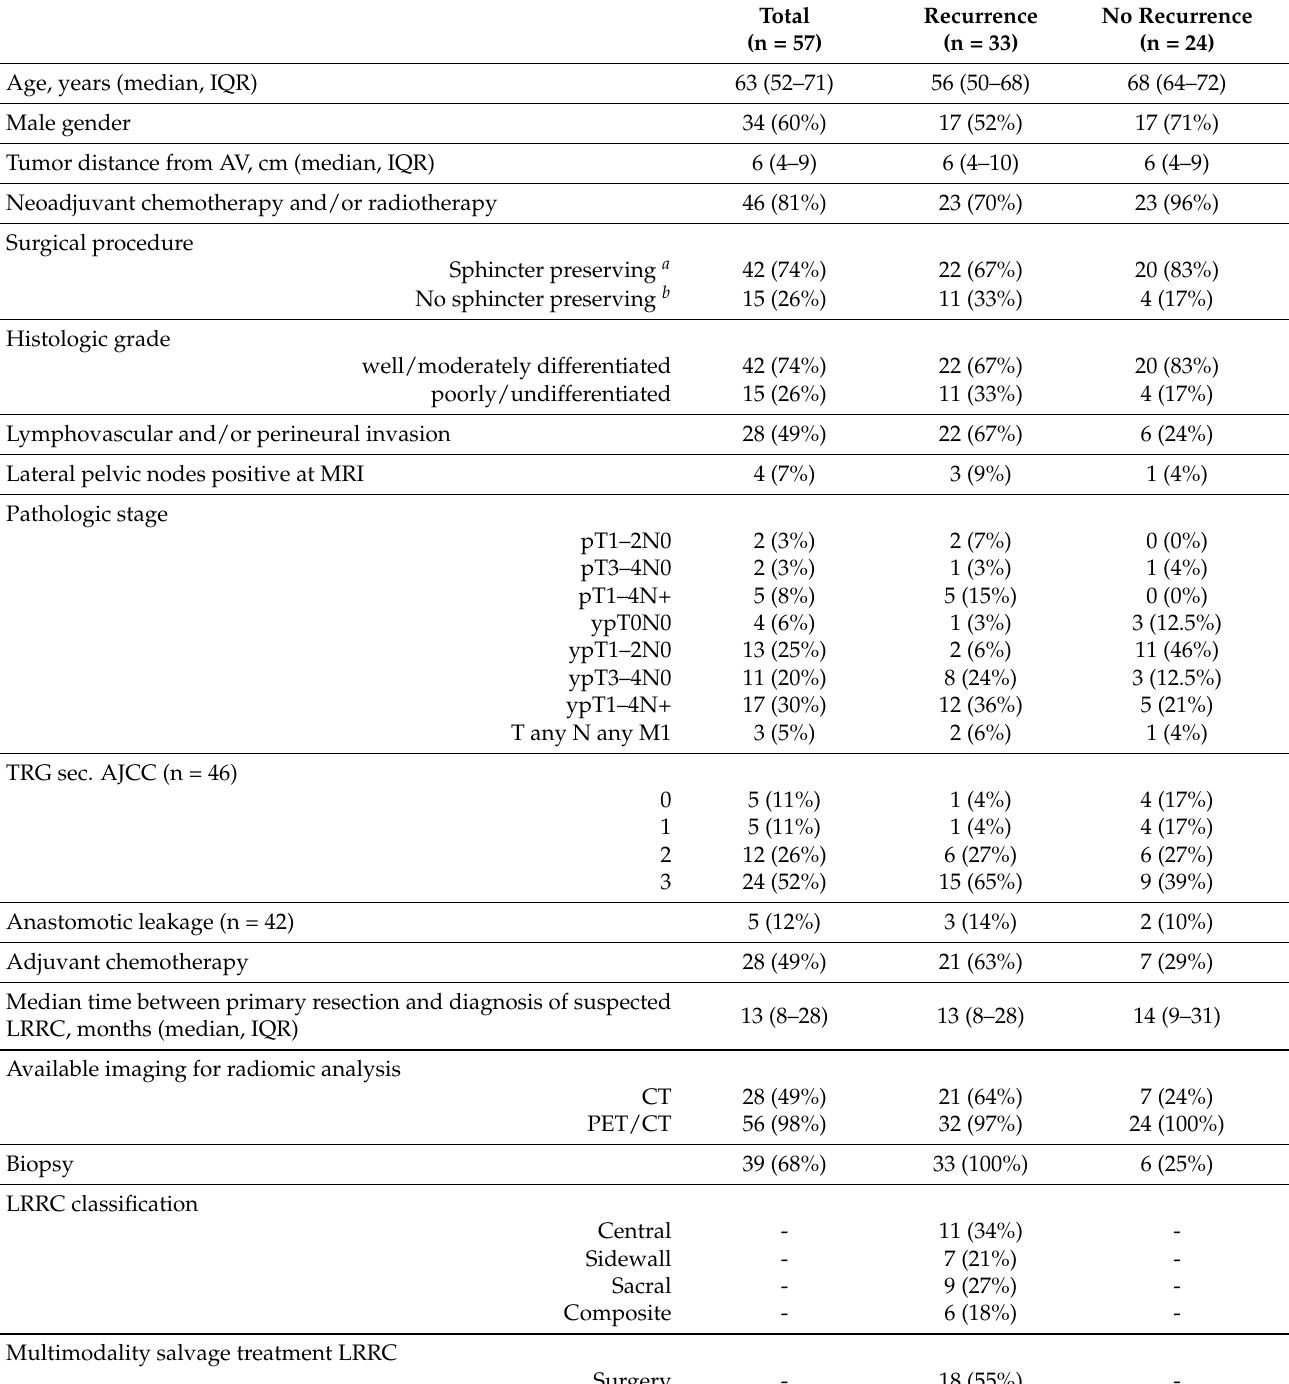
Table 1. Patients’ primary rectal cancer and pelvic recurrence